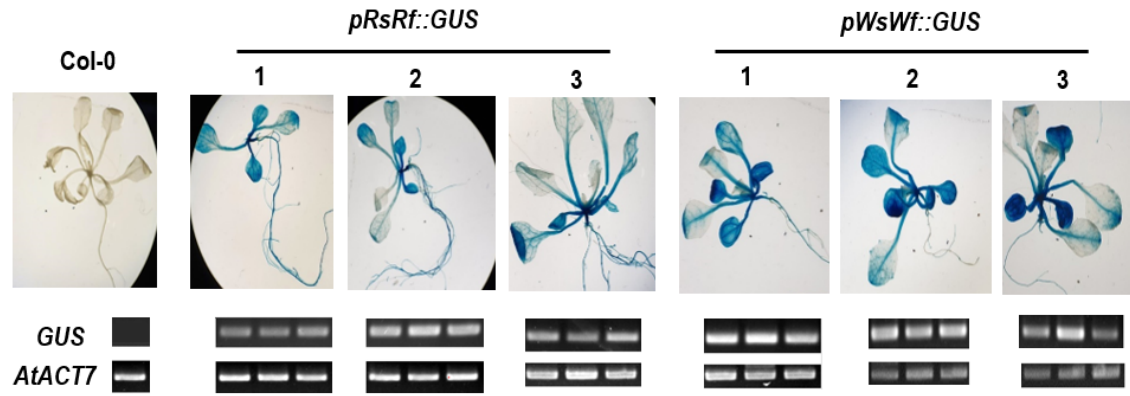
Figure 6. Promoter activity assay by GUS stain and RT ‐ PCR.